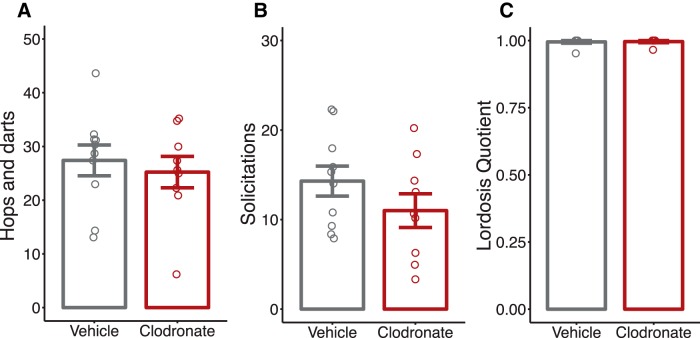
Adult female sex behavior is unchanged after postnatal microglia depletion. Quantification of female sexual proceptivity: number of hops and darts (a) and solicitations (b) and receptivity lordosis quotient (c). Solid bars indicate group means ± SEM for VEH-treated (black) and LC-treated (red) female rats. Open circles represent data from individual rats. n = 9–10 per treatment.